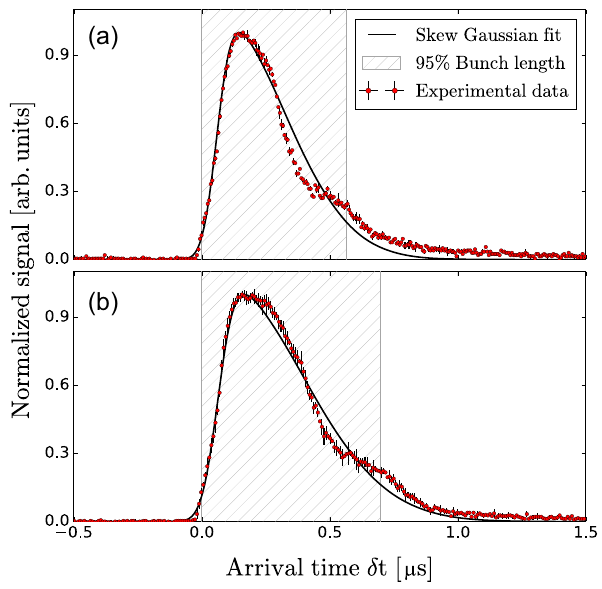
FIG. 14. Measurement showing the time structure of a 48-eV e þ bunch (a) immediately before the interconnect and (b) at the LDS. Data were collected using a PMT-backed scintillator panel installed beside the interconnect and averaged over three identical trials. The error bars reflect the standard error of the distribution of measurements. To aid comparison, the horizontal axis is shifted relative to the onset of each signal.